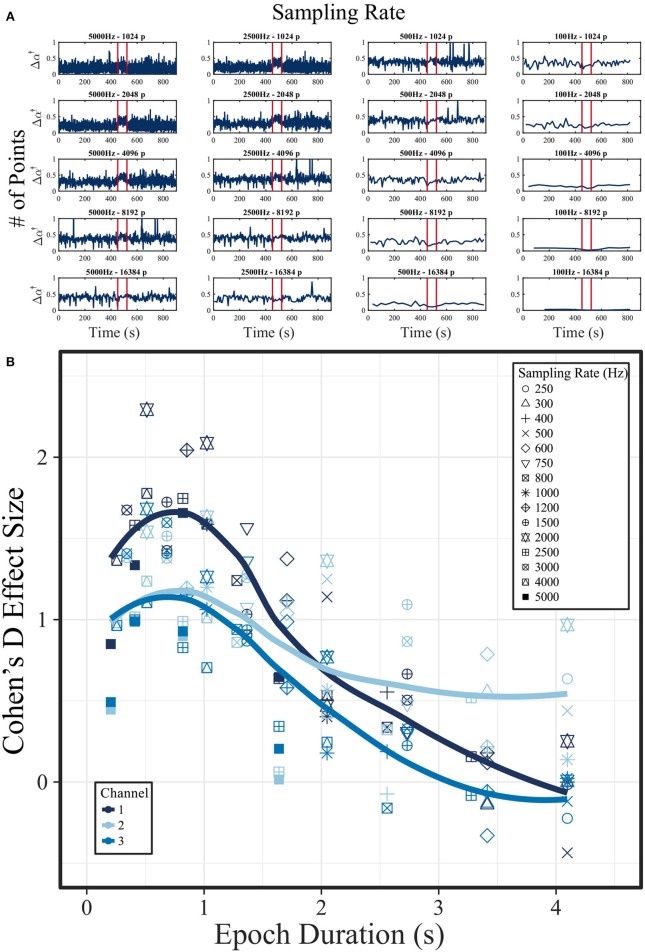
Influence of EEG sampling frequency and epoch length on multifractal spectrum width around and during an epileptic seizure. (A) Multifractal spectrum width (Δα†) in a 15-min intracranial EEG segment containing one seizure (onset and offset marked by the red lines). The signal was initially sampled at 5,000 Hz. Each column shows Δα† for 5,000, 2,500, 500, and 100 Hz sampling rates. Different epoch sizes were used ranging from 1,024 to 16,384 samples (in each row). (B) Relationship of effect size D (between the interictal and ictal distribution of Δα†) and epoch duration in seconds (obtained by dividing the number of sampling points by the sampling rate of the signal). Channel 1 is the data shown in (A). The solid line represents a LOESS curve fitting of the data points, with formula “y ~ x.” The data used for this figure is obtained from for subject “I001_P005_D01” around seizure 1. Channel 1: ADMacro_01. Channel 2: ADMacro_02. Channel 3: ADMacro_03.